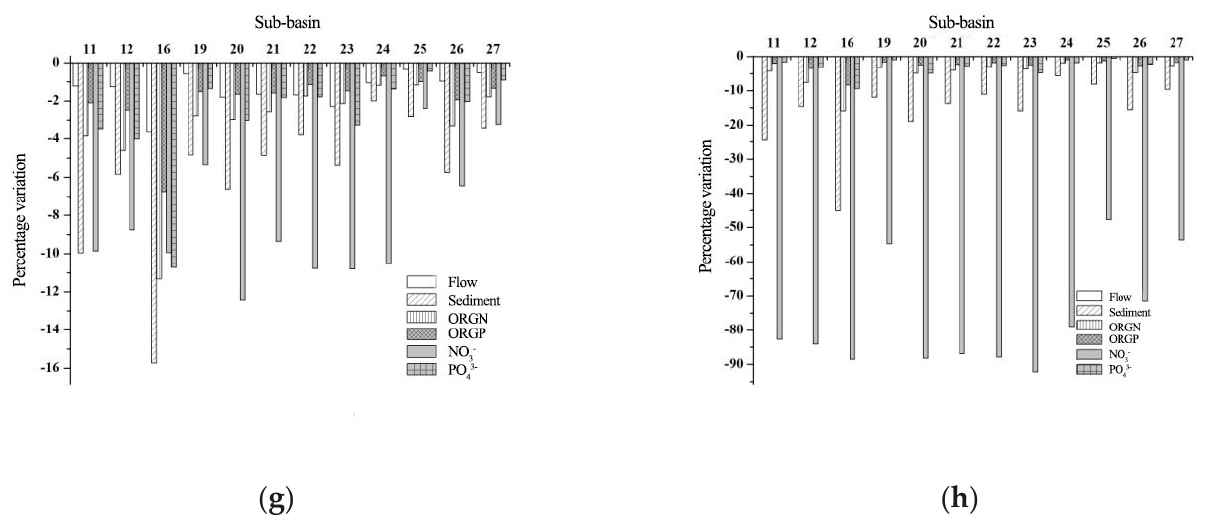
Figure 4. Pollutants percentage changes between the baseline and the scenarios in different subbasins; ( a ) Filter belt. ( b ) Land levelling. ( c ) Bedding and piping system-ditch expansion and reservoir. ( d ) Bedding and piping system-no ditch improved. ( e ) Bedding and piping system-tail water irrigation. ( f ) Bedding and piping system-two stage ditches. ( g ) Permanent dams. ( h ) Ponds. Table 5. Construction costs of